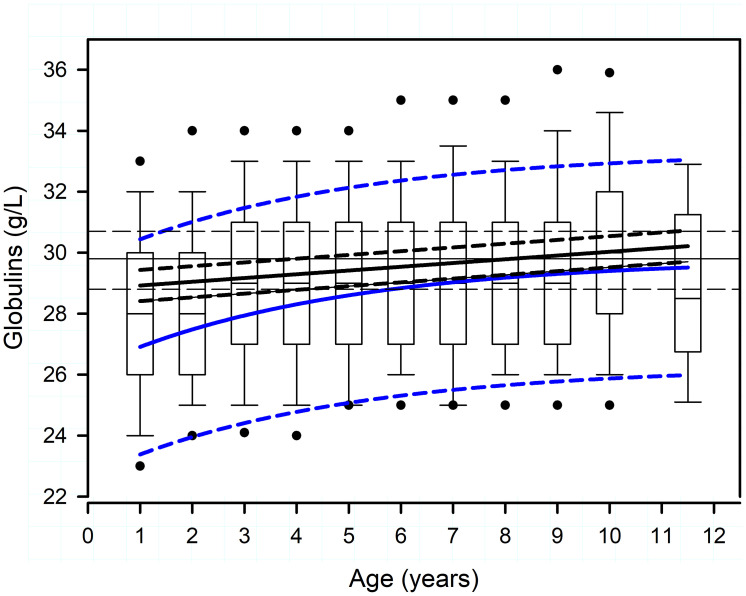
Box plots of the change in serum globulin concentration in female (n = 1,866) and male (n = 2,932) dogs being considered for running in the Iditarod Trail Sled Dog Race in 195 teams during a seven-year study period.There are 9,737 data points from 4,798 dogs. The box plot represents the first quartile, median, and third quartile, and the whiskers represent the 90 percentile limits. The filled circles represent the 5th and 95th percentile limits. The solid line is the regression line adjusted for repeated measures for female (blue line) and male (black line) dogs, as well as the effect of musher and year of sampling. The dashed lines represent the 95% prediction interval for the female and male regression lines. The thin solid line and thin dashed lines represent the asymptotic value for females and its 95% confidence interval, respectively.